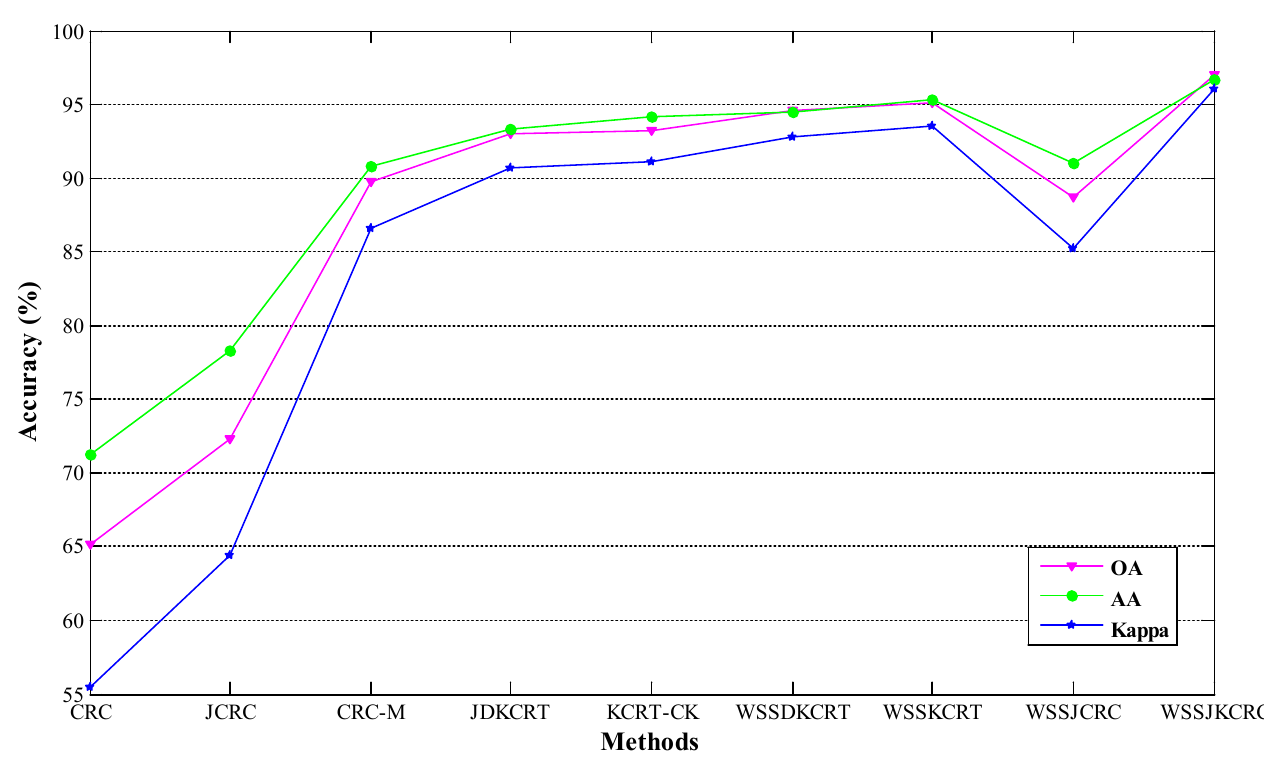
Figure 12. The OA, AA, and Kappa values for different methods on the Pavia University scene.